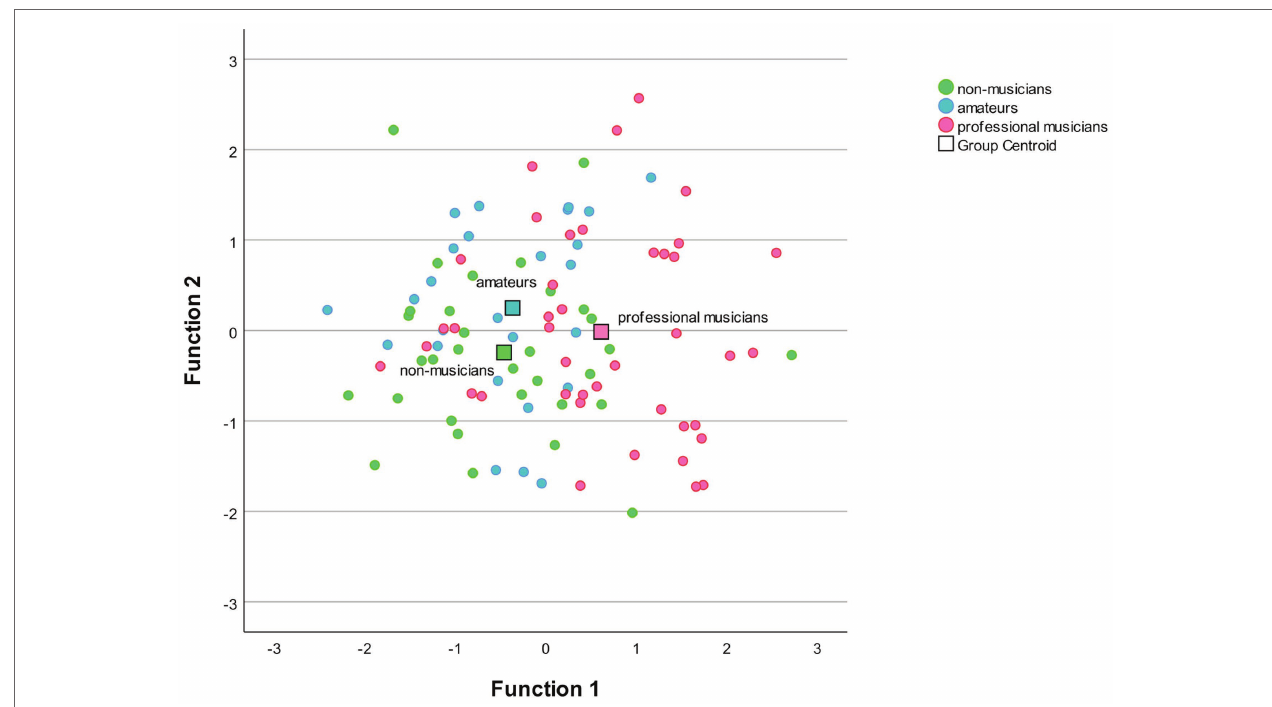
FIGURE 2 | The figure illustrates the discriminant function of the three Mandarin measures. The horizontal axis represents the significant discriminant function, function 1. It discriminates the professional musicians from the amateurs and the non-musicians. The correlations between the outcome variables and the discriminant functions revealed that all three Mandarin variables load onto the first function illustrating that the professional musicians performed significantly better in Mandarin than both other groups. The vertical axis represents the second-discriminant function, function 2. Since this function was non-significant it will not be further